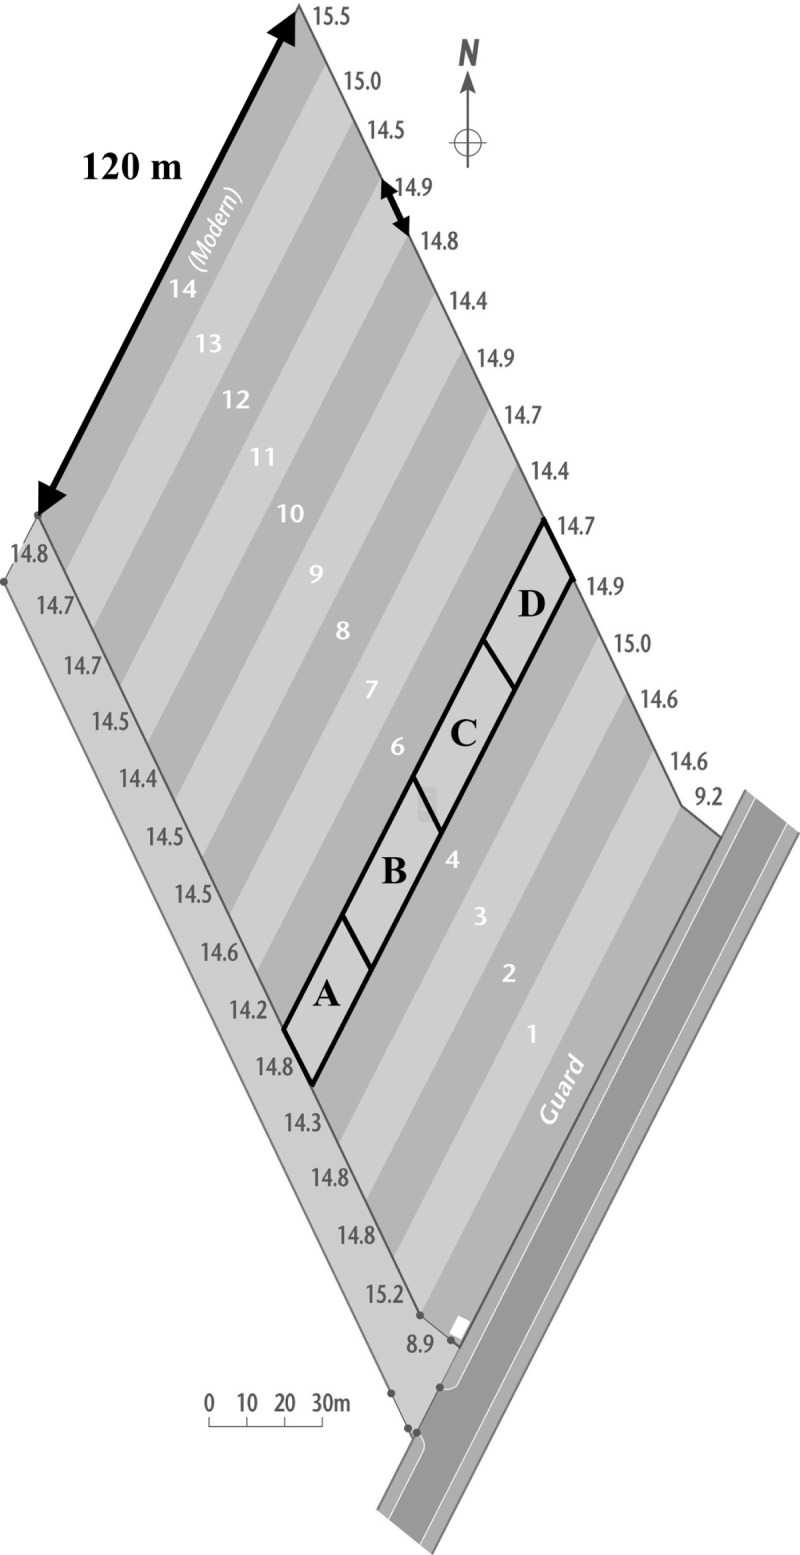
Palace Leas Hay Meadow Experiment layout.Illustration in plot 5 of how the treatment plots were divided into the four blocks; A-D. The length (northern edge) and individual treatment plots widths (eastern and western edge) are labelled in the diagram.